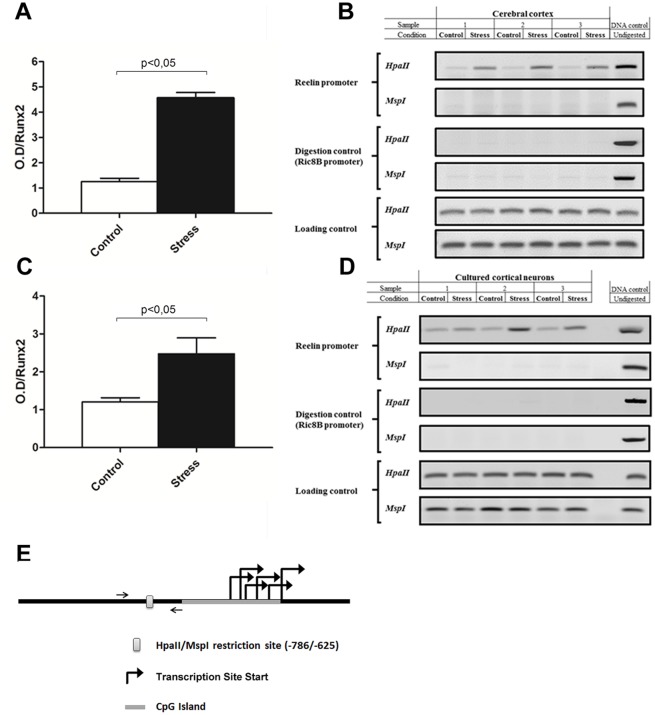

In vitro (A) and in vivo (C) analyses of DNA methylation at the reelin gene promoter region in samples from control and stress groups.Genomic DNA obtained from both groups was cleaved with DNA methylation sensitive restriction enzyme HpaII and then amplified by conventional PCR using specific primers against a reelin promoter region containing an HpaII site (-786/-625). Undigested genomic DNA is included as amplification control in all PCR reactions. Efficient digestion of DNA samples using the HpaII enzyme was controlled by analyzing a region devoid of DNA methylation at the Ric-8B gene promoter containing several HpaII cleavage sites (digestion control). A region of the Runx2 gene promoter lacking HpaII sites was selected to show equal sample loading in each lane of the gels. Digestion with the isoschizomer restriction enzyme MspI (DNA methylation insensitive) was also performed to control for efficient cleavage at the reelin promoter sequence analyzed (Data not shown). DNA methylation differences between control and stress rats groups measured in vivo (B) and in vitro (D) were quantified by determining changes in pixel density at the bands amplified by PCR and visualized through conventional DNA electrophoresis (see methods). (E), diagram depicting the selected upstream promoter region with its putative methylation sites. The reelin promoter has several transcription site starts over the CpG island. Upstream the promoter is the HpaII/MspI restriction site that was selected for our analyses. Values are expressed as relative ratios between PCR amplifications of the reelin promoter sequence after digestion with HpaII over the amplifications of the Runx2 control promoter sequence (loading control). Values represent a mean ± SEM. N = 3 per group. *p<0.05.